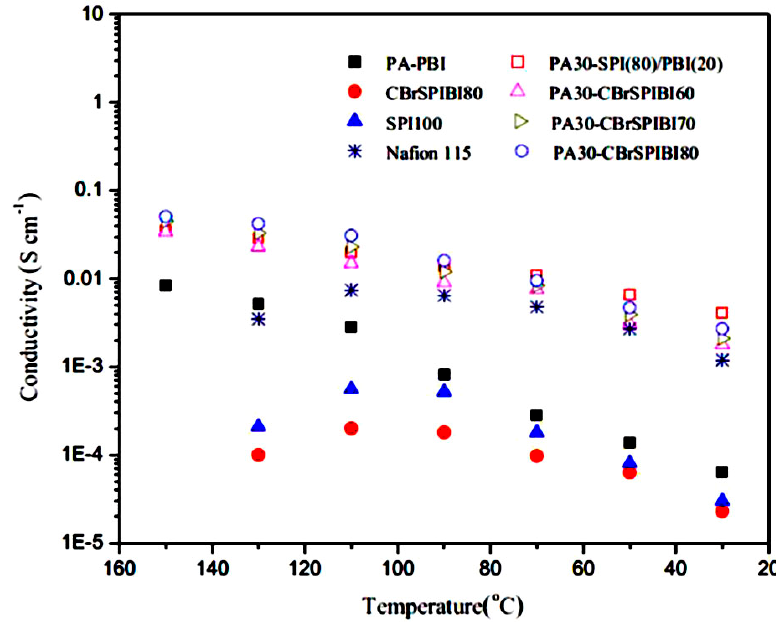
Figure 13. Temperature dependence of the conductivity of PA-CBrSPIBI, PA-SPI / PBI, CBrSPIBI80, SPI100, Nafion 115andPA-PBIat30%RH. Reproduced with permission from [100]. Copyright Elsevier, 2016.